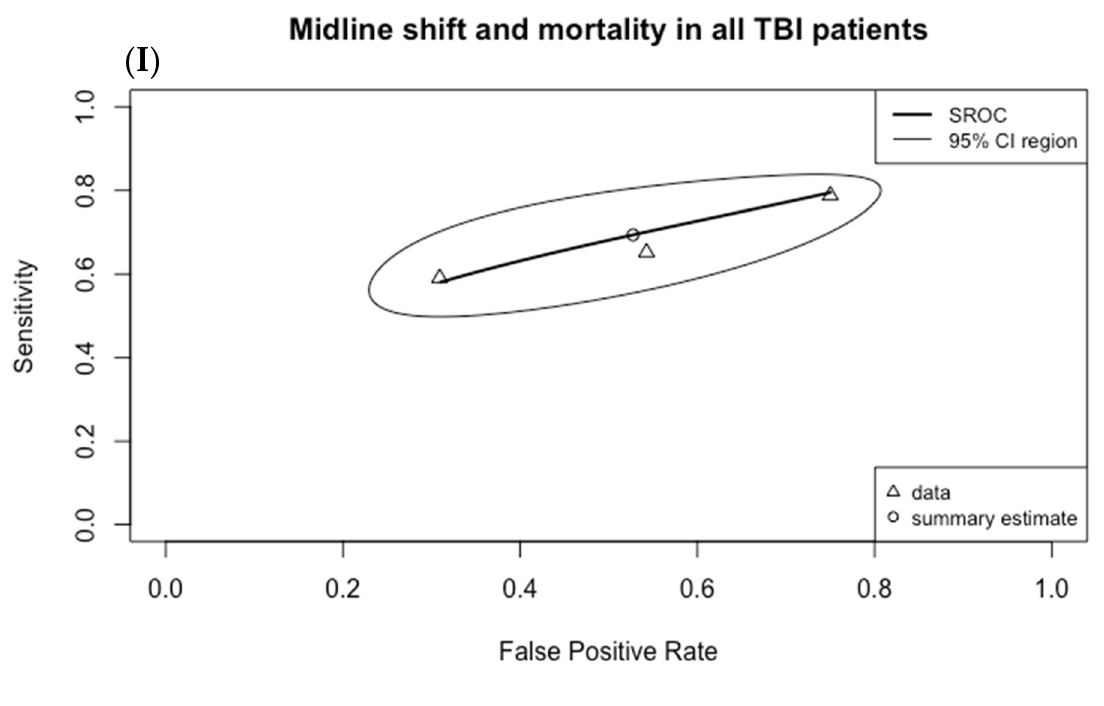
Figure 4. Summary ROC curves (SROC; bivariate model) for mortality in adult TBI patients for ( A ) subarachnoid hemorrhage (SAH), ( B ) subdural hematoma (SDH), ( C ) epidural hematoma (EDH), ( D ) intraventricular hemorrhage (IVH), ( E ) intraparenchymal hematoma (IPH), ( F ) cerebral contusion, ( G ) basal cistern compression, ( H ) cerebral edema, and ( I ) midline shift. Only SDH had both an AUC with 95% CI not crossing 0.5 and a DOR with 95% CI not crossing 1, at 0.593 (95% CI: 0.556–0.725) and 2.755 (95% CI: 1.474–5.148), respectively.